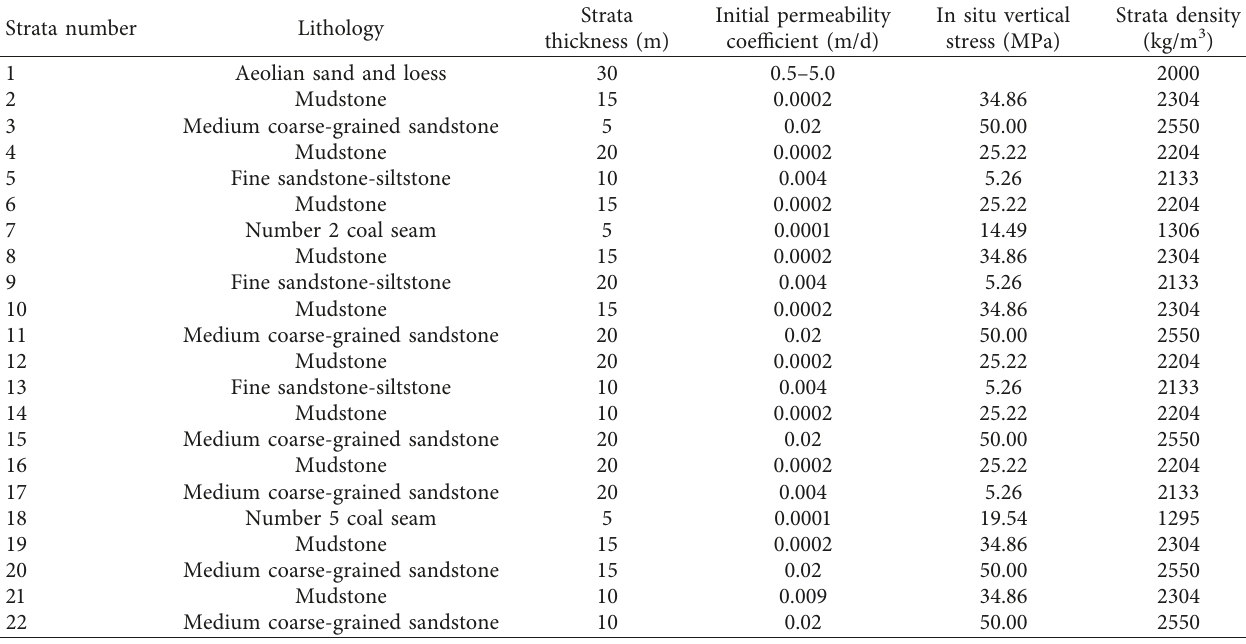
Table 1: Site stratigraphy and physical properties.